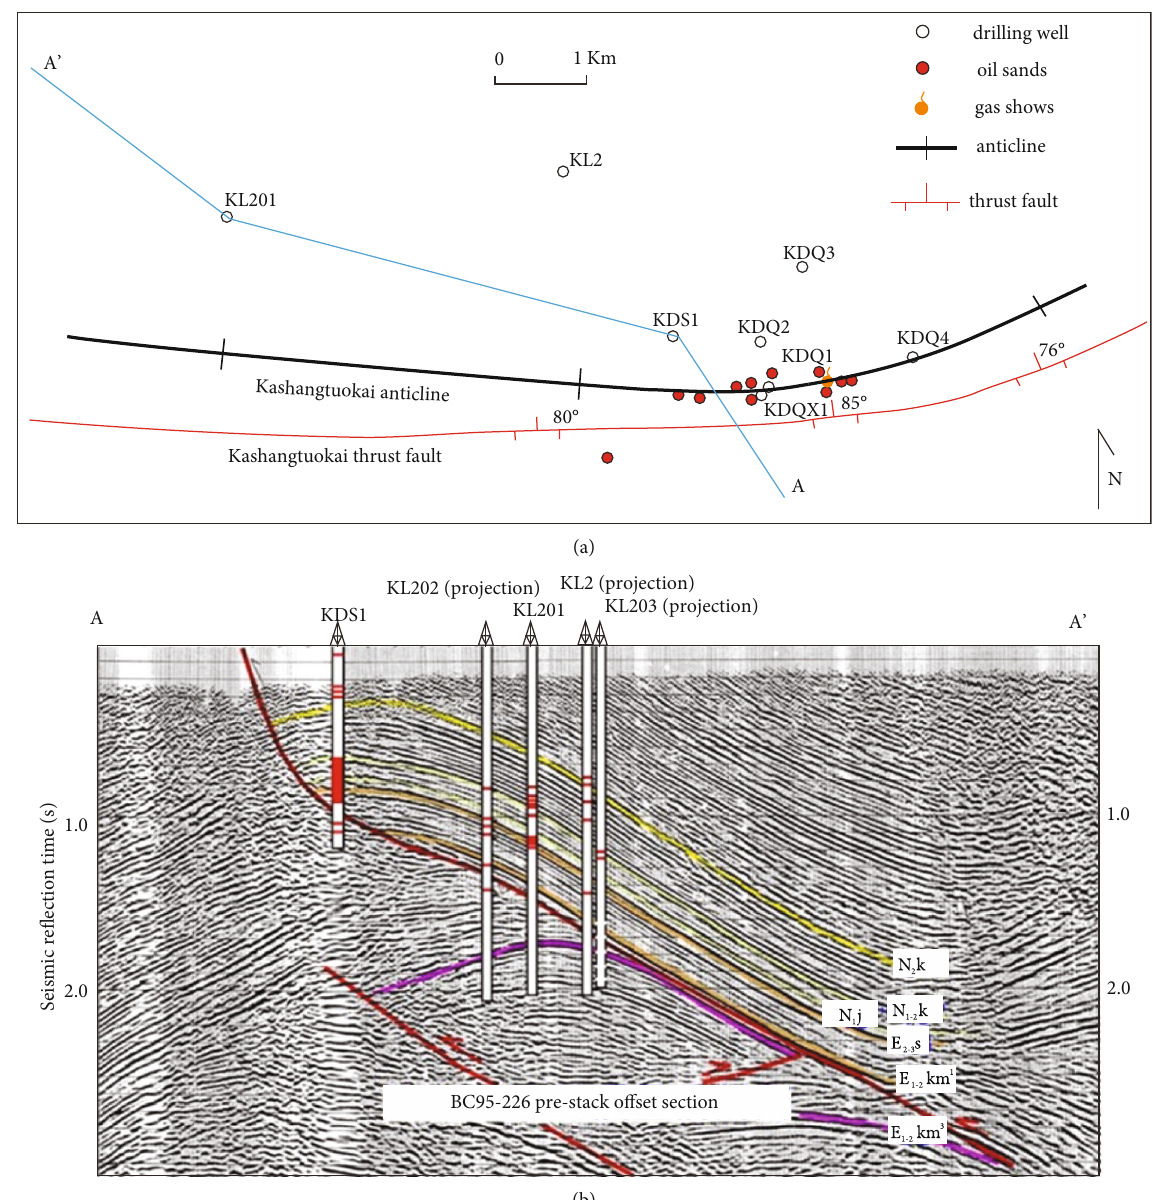
Figure 9: Surface structure and oil and gas shows in the Kela-2 gas fi eld. (a) Surface geological and structural map of the Kela-2 gas fi eld, showing the Kashangtuokai thrust fault and anticline, and the locations of wells and oil and gas shows. (b) Seismic section showing the structure of Kela-2 and its relationship to the Kashangtuokai thrust